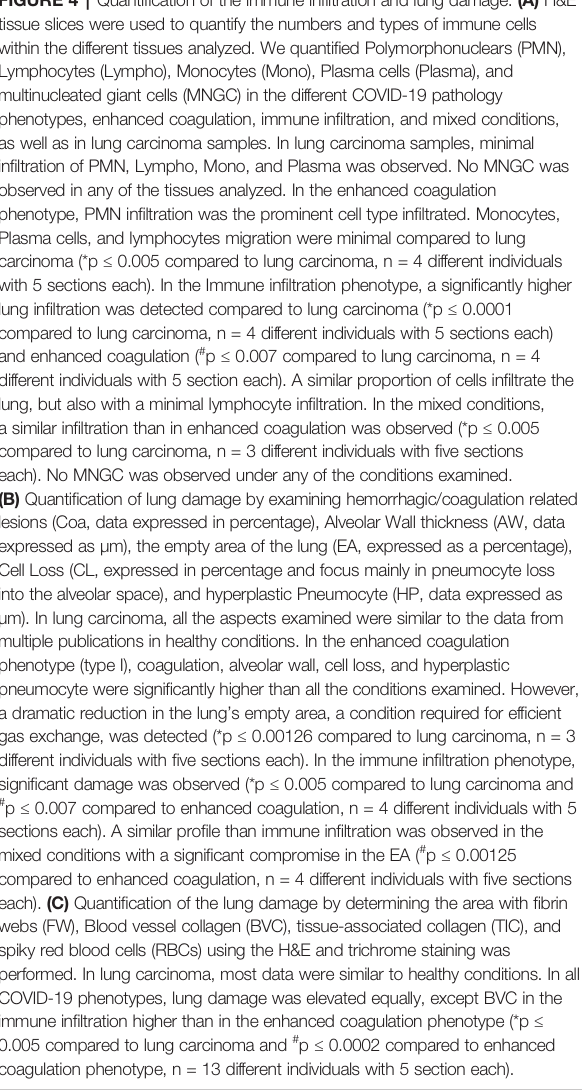
FIGURE 4 | Quanti fi cation of the immune in fi ltration and lung damage. (A) H&E tissue slices were used to quantify the numbers and types of immune cells within the different tissues analyzed. We quanti fi ed Polymorphonuclears (PMN), Lymphocytes (Lympho), Monocytes (Mono), Plasma cells (Plasma), and multinucleated giant cells (MNGC) in the different COVID-19 pathology phenotypes, enhanced coagulation, immune in fi ltration, and mixed conditions, as well as in lung carcinoma samples. In lung carcinoma samples, minimal in fi ltration of PMN, Lympho, Mono, and Plasma was observed. No MNGC was observed in any of the tissues analyzed. In the enhanced coagulation phenotype, PMN in fi ltration was the prominent cell type in fi ltrated. Monocytes, Plasma cells, and lymphocytes migration were minimal compared to lung carcinoma (*p ≤ 0.005 compared to lung carcinoma, n = 4 different individuals with 5 sections each). In the Immune in fi ltration phenotype, a signi fi cantly higher lung in fi ltration was detected compared to lung carcinoma (*p ≤ 0.0001 compared to lung carcinoma, n = 4 different individuals with 5 sections each) and enhanced coagulation ( # p ≤ 0.007 compared to lung carcinoma, n = 4 different individuals with 5 section each). A similar proportion of cells in fi ltrate the lung, but also with a minimal lymphocyte in fi ltration. In the mixed conditions, a similar in fi ltration than in enhanced coagulation was observed (*p ≤ 0.005 compared to lung carcinoma, n = 3 different individuals with fi ve sections each). No MNGC was observed under any of the conditions examined. (B) Quanti fi cation of lung damage by examining hemorrhagic/coagulation related lesions (Coa, data expressed in percentage), Alveolar Wall thickness (AW, data expressed as µm), the empty area of the lung (EA, expressed as a percentage), Cell Loss (CL, expressed in percentage and focus mainly in pneumocyte loss into the alveolar space), and hyperplastic Pneumocyte (HP, data expressed as µm). In lung carcinoma, all the aspects examined were similar to the data from multiple publications in healthy conditions. In the enhanced coagulation phenotype (type I), coagulation, alveolar wall, cell loss, and hyperplastic pneumocyte were signi fi cantly higher than all the conditions examined. However, a dramatic reduction in the lung ’ s empty area, a condition required for ef fi cient gas exchange, was detected (*p ≤ 0.00126 compared to lung carcinoma, n = 3 different individuals with fi ve sections each). In the immune in fi ltration phenotype, signi fi cant damage was observed (*p ≤ 0.005 compared to lung carcinoma and # p ≤ 0.007 compared to enhanced coagulation, n = 4 different individuals with 5 sections each). A similar pro fi le than immune in fi ltration was observed in the mixed conditions with a signi fi cant compromise in the EA ( # p ≤ 0.00125 compared to enhanced coagulation, n = 4 different individuals with fi ve sections each). (C) Quanti fi cation of the lung damage by determining the area with fi brin webs (FW), Blood vessel collagen (BVC), tissue-associated collagen (TIC), and spiky red blood cells (RBCs) using the H&E and trichrome staining was performed. In lung carcinoma, most data were similar to healthy conditions. In all COVID-19 phenotypes, lung damage was elevated equally, except BVC in the immune in fi ltration higher than in the enhanced coagulation phenotype (*p ≤ 0.005 compared to lung carcinoma and # p ≤ 0.0002 compared to enhanced coagulation phenotype, n = 13 different individuals with 5 section